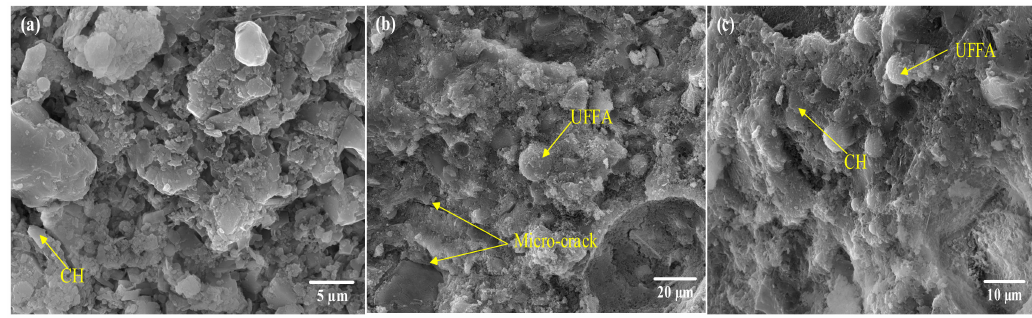
Figure 11. Microstructure of the ( a ) control mix, ( b ) 10% UFFA, and ( c ) 5% MK under 400 ◦ C.